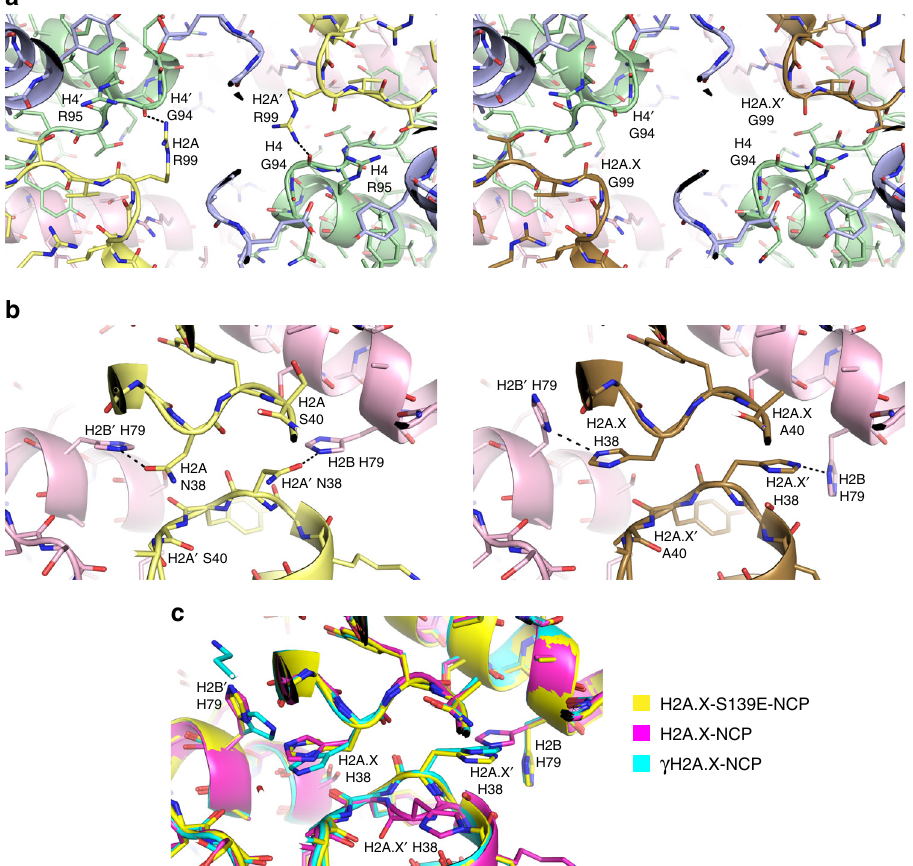
Fig. 3 Structural differences between H2A and H2A.X nucleosomes. a The dimer – tetramer – dimer interface around the centre of the histone octamer. b The dimer – dimer interface. a , b Carbon atoms of histone proteins are coloured by type: H2A (left side), yellow; H2A.X (right side), bronze; H2B, pink; H3, purple; H4, green. c Comparison of dimer – dimer interface conformation between the three H2A.X-NCP